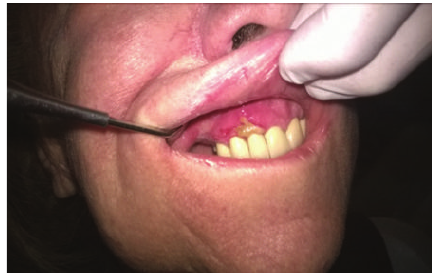
Figure 2: Propolis induced oral lesions.